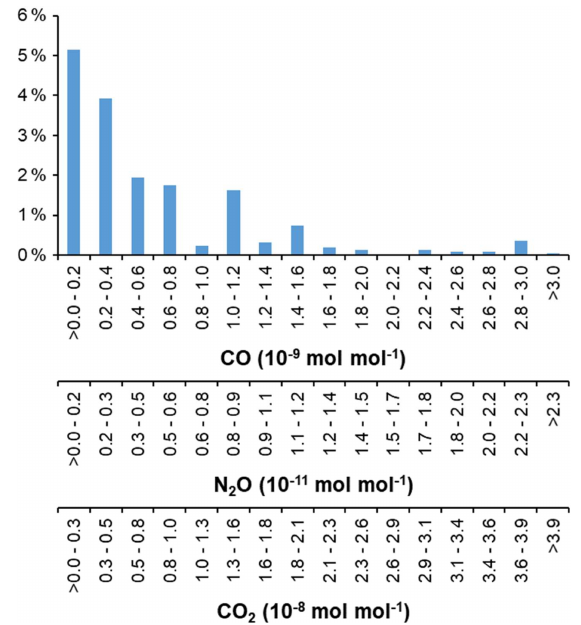
Figure 8. Frequency distribution of the excess concentrations at the measuring point allocated to emission sources in the village. Cases of zero excess (83.2%) are not presented. The distribution is the same for all components, but the scales are different. Note: scales for N 2 O and CO 2 are rounded and based on the CO